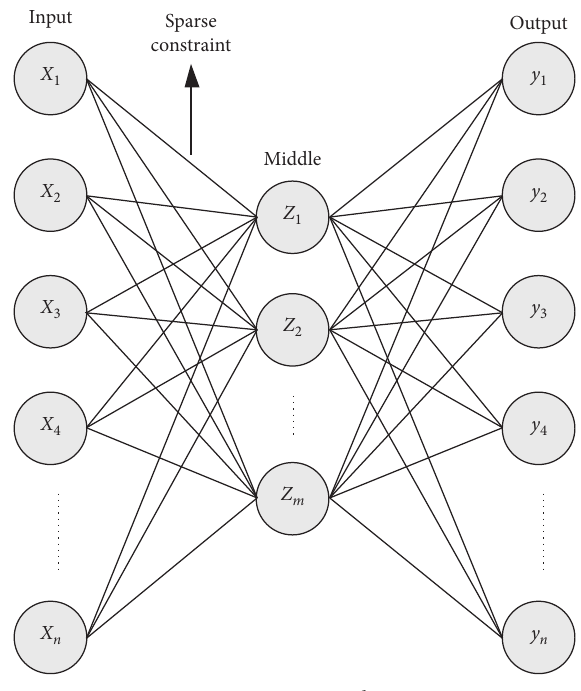
Figure 1: Sparse autoencoder